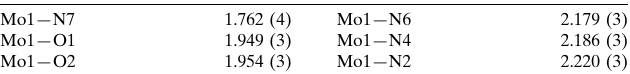
Selected bond lengths (A˚ ).